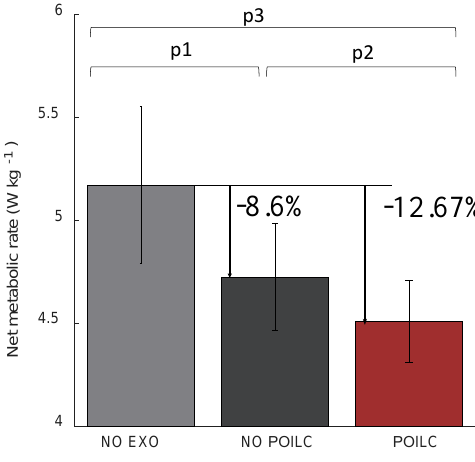
Figure 11. The metabolic reduction when walking on the flat ground. The NO EXO, NO ILC, and ILC present the case of not wearing soft exoskeleton, and wearing exoskeleton without and with POILC method. p1, p2, and p3 are the result of two-side t-tests, which are 0.002, 0.134, and 0.006,